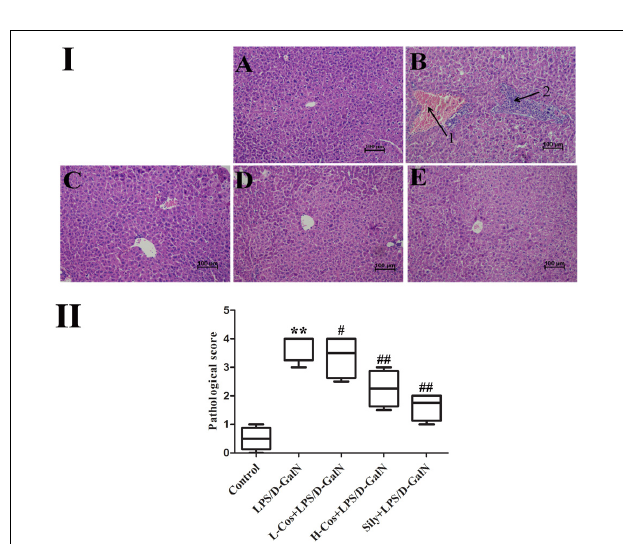
FIGURE 3 | Effects of cos on liver histology in mice. (I) The histopathological changes of liver. (I-A) Control, (I-B) LPS/ D -GalN (LPS 50 µ g/kg; D -GalN: 400 mg/kg; arrow 1: central venous hyperemia; arrow 2: inflammatory infiltration), (I-C) LPS/ D -GalN + L-cos ( I-B + cos 20 mg/kg), (I-D) LPS/ D -GalN + H-cos ( I-B + cos 40 mg/kg), (I-E) LPS/ D -GalN + sily ( I-B + cos 40 mg/kg) (magnification: 200 × ). (II) The scores of the liver injury in the mice after treated with cos. The data represented as mean ± SD ( n = 10). ∗∗ P < 0.01 vs. Control group; # P < 0.05, ## P < 0.01 vs. LPS/ D -GalN